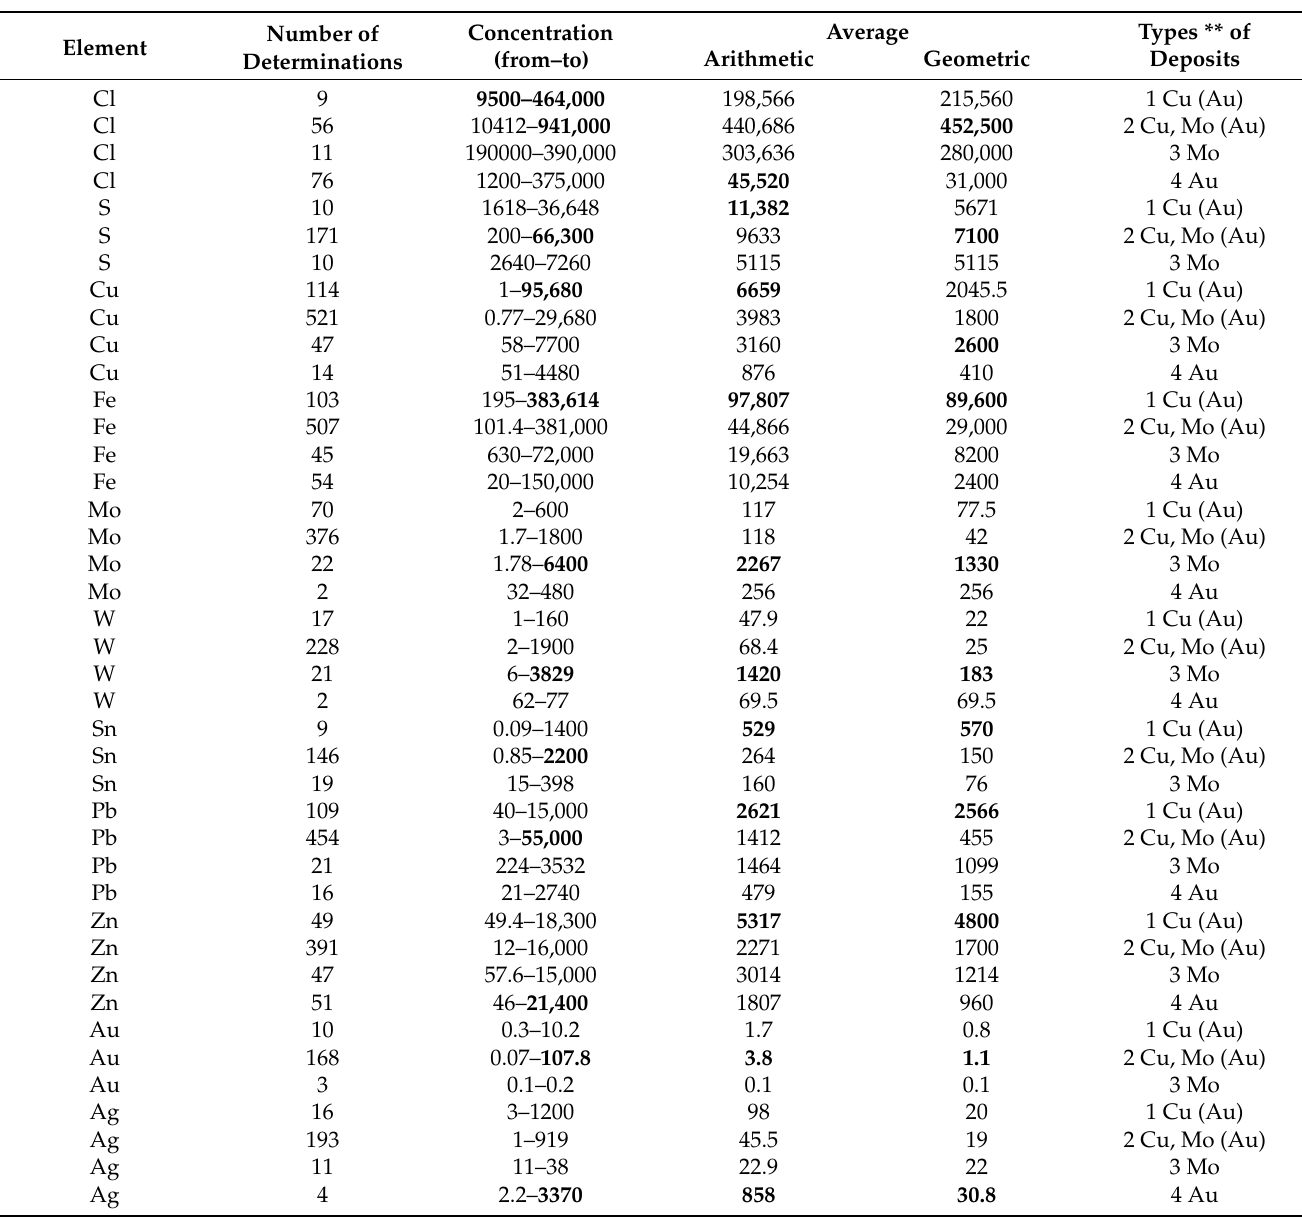
Table 5. Concentrations (ppm) of some elements in mineralizing fluids at porphyry deposits * of various